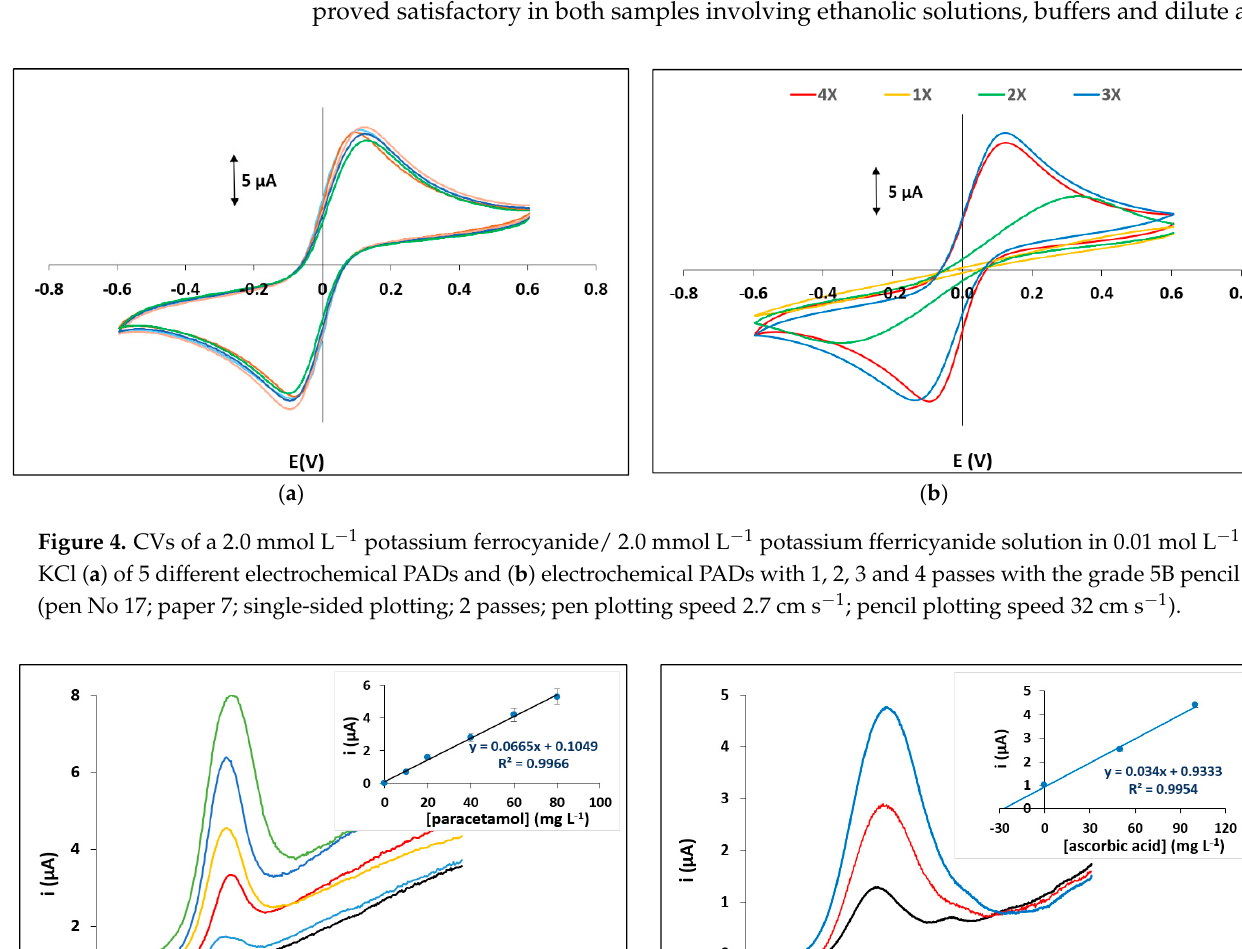
Figure 3. Assay of total phenols using gallic acid as standard: ( a ) calibration plot and photos of the assay at different gallic acid concentrations of fluidic and circular PADs, ( b ) photos illustrating between-device reproducibility at 3 concentration levels (pen No 17; paper 7; single-sided plotting; 2 passes; pen plotting speed 2.7 cm − 1 ).